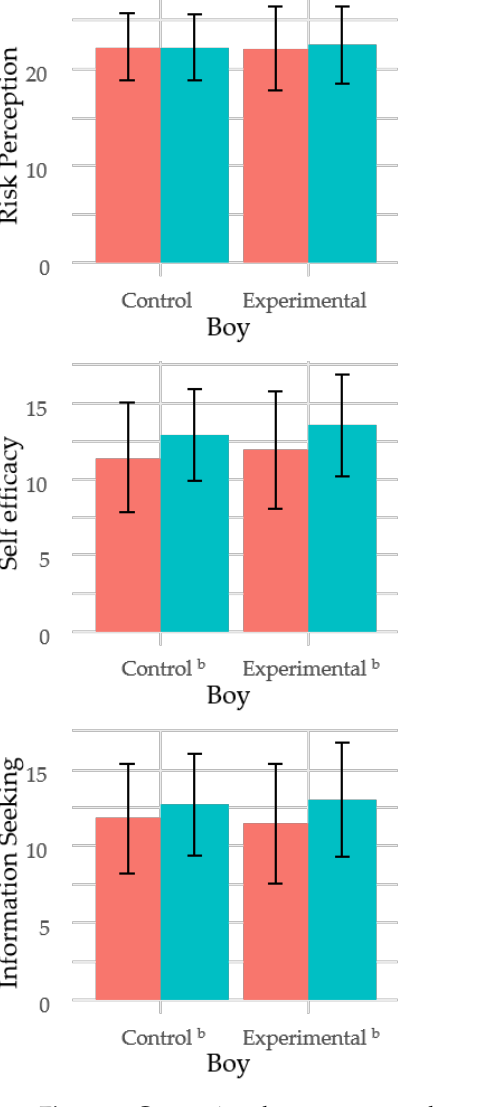
Figure 1. Comparison between pre- and post-test scores stratified by gender. a The p -values represent the score di ff erences between the pre- and post-tests. b p <